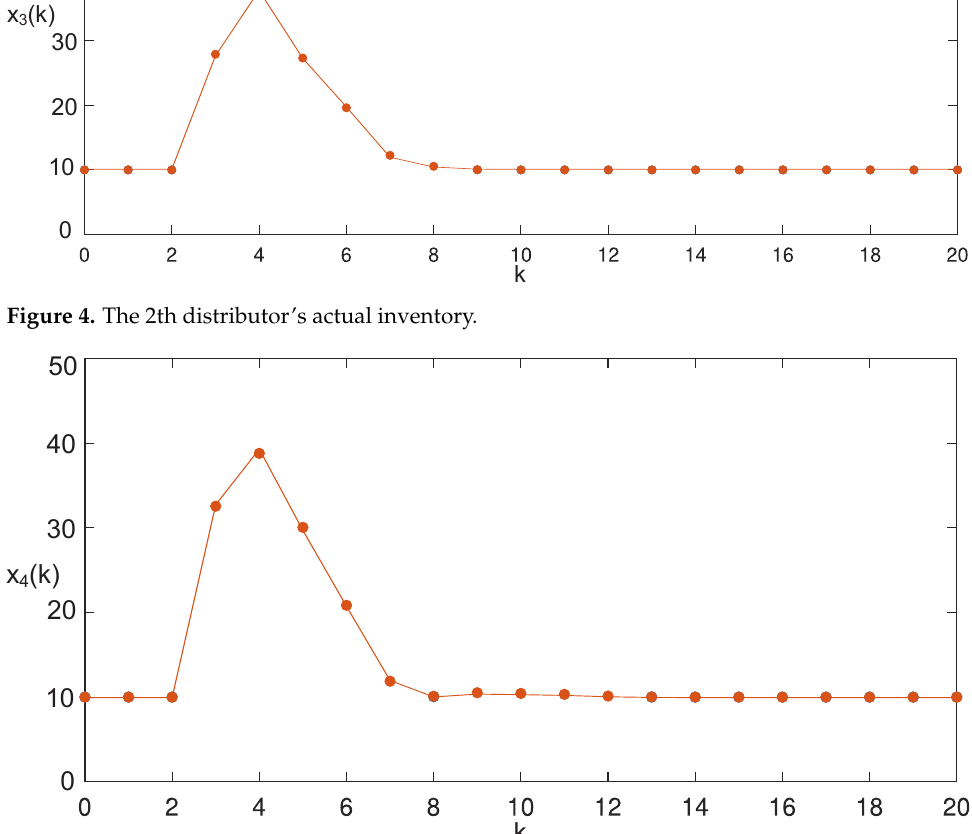
Fig. 6. Output-feedback closed-loop response to the impulsive distur- bance w ( k ) in Fig. 2 (top-left panel).